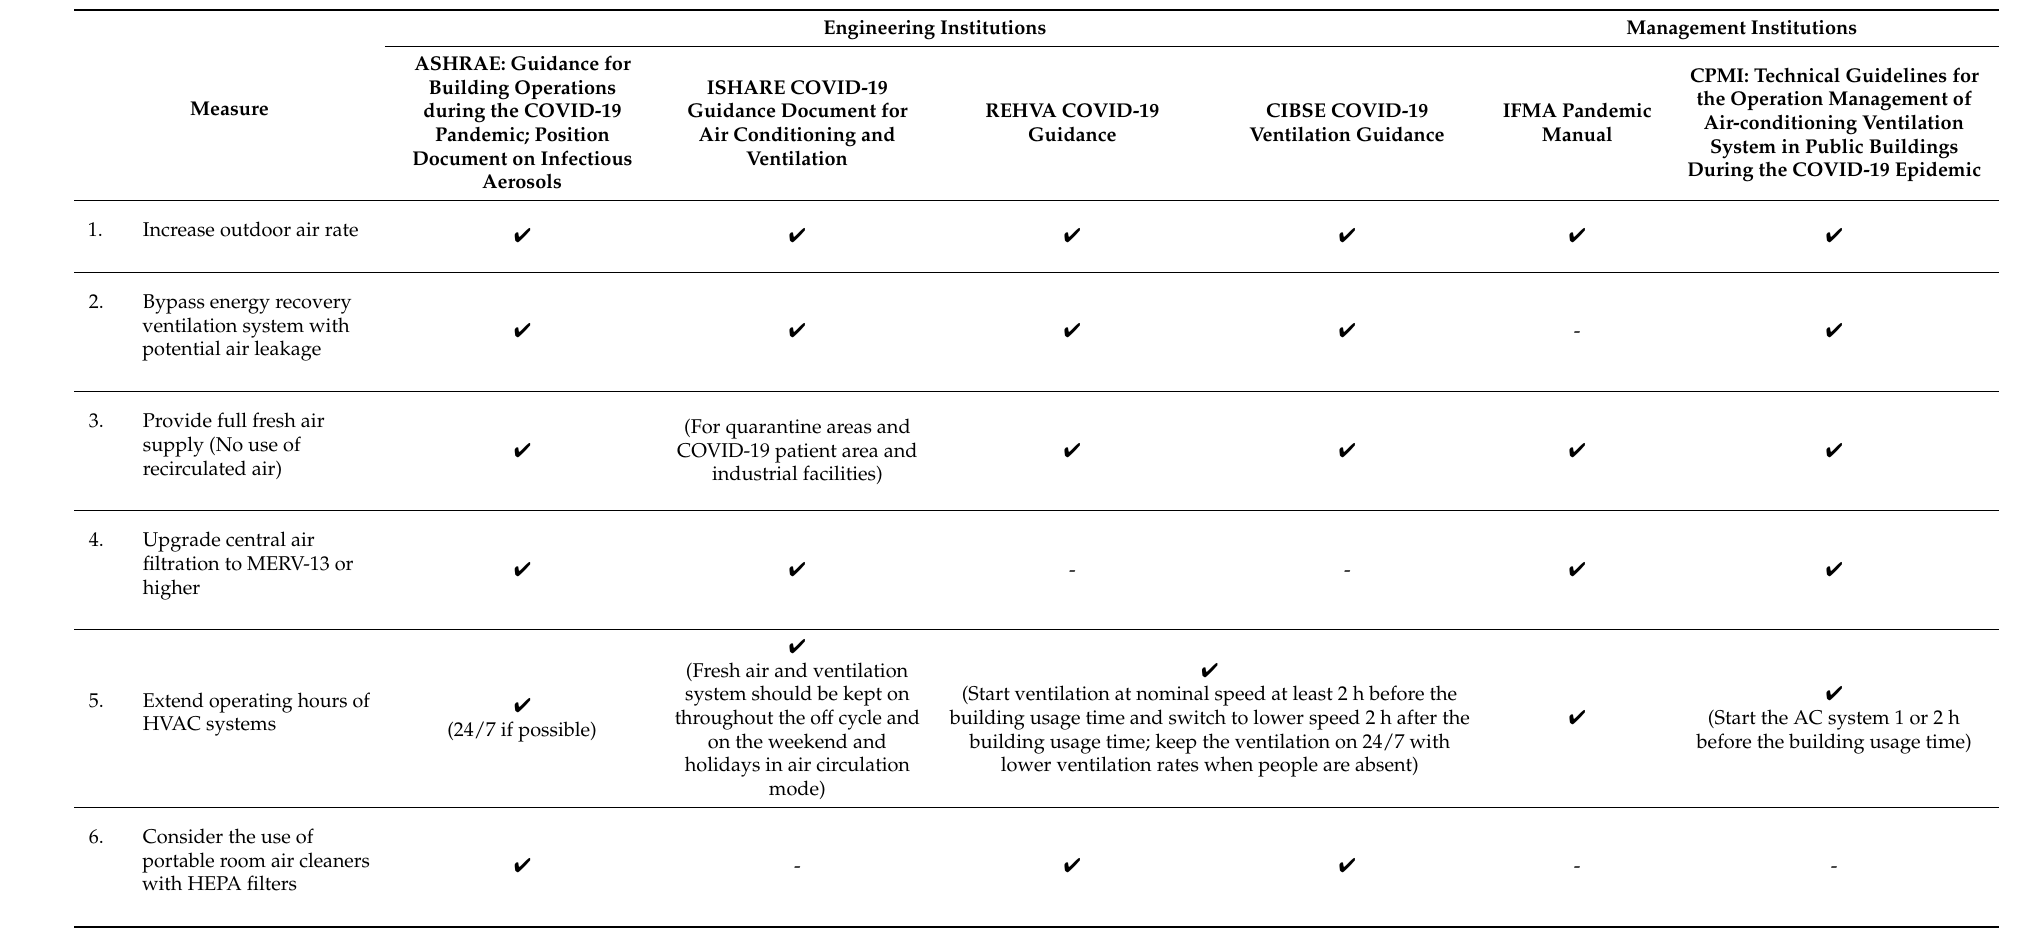
Table 3. Measures for strengthening indoor air quality or